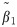
The estimate of β
1 (or β˜1) and its standard error for data simulated under ZINB when ϕ
c = 20% and γ
1 = 0.4.The figure displays box-plots of estimates and their standard errors for the covariate effect on the log-odds of structural zeros for ZIP and ZINB method and on the log-odds of zeros for hurdle models from 1000 replications when γ
1 = 0.4. For each box of the boxplots, the center line represents the median, the bottom line represents the 25th percentiles and the top line represents the 75th percentiles. The whiskers of the boxplots show 1.5 interquartile range (IQR) below the 25th percentiles and 1.5 IQR above the 75th percentiles, and outliers are represented by small circles. Panels (A1), (C1) and (E1) show the estimates of β
1 for consonant, neutral and dissonant effect case, respectively. The horizontal line in these panels represents the true value of β
1, which is −0.349 in (A1), 0 in (C1) and 0.287 in (E1). Panels (A2), (C2) and (E2) show the estimates of β˜1 for consonant, neutral and dissonant effect case, respectively. The horizontal line in these panels represents the true value of β˜1, which is −0.420 in (A2), −0.240 in (C2) and −0.070 in (E2). The bias, standard deviation (SD), and root mean square error (RMSE) of the estimates are shown above the box-plot for each method. Panel (B1), (D1) and (F1) show the SEs of the estimates for β
1, and panel (B2), (D2) and (F2) show the SEs of the estimates for β˜1. The mean and standard deviation (SD) of the standard error (SE) estimations are shown above the box-plot for each method.